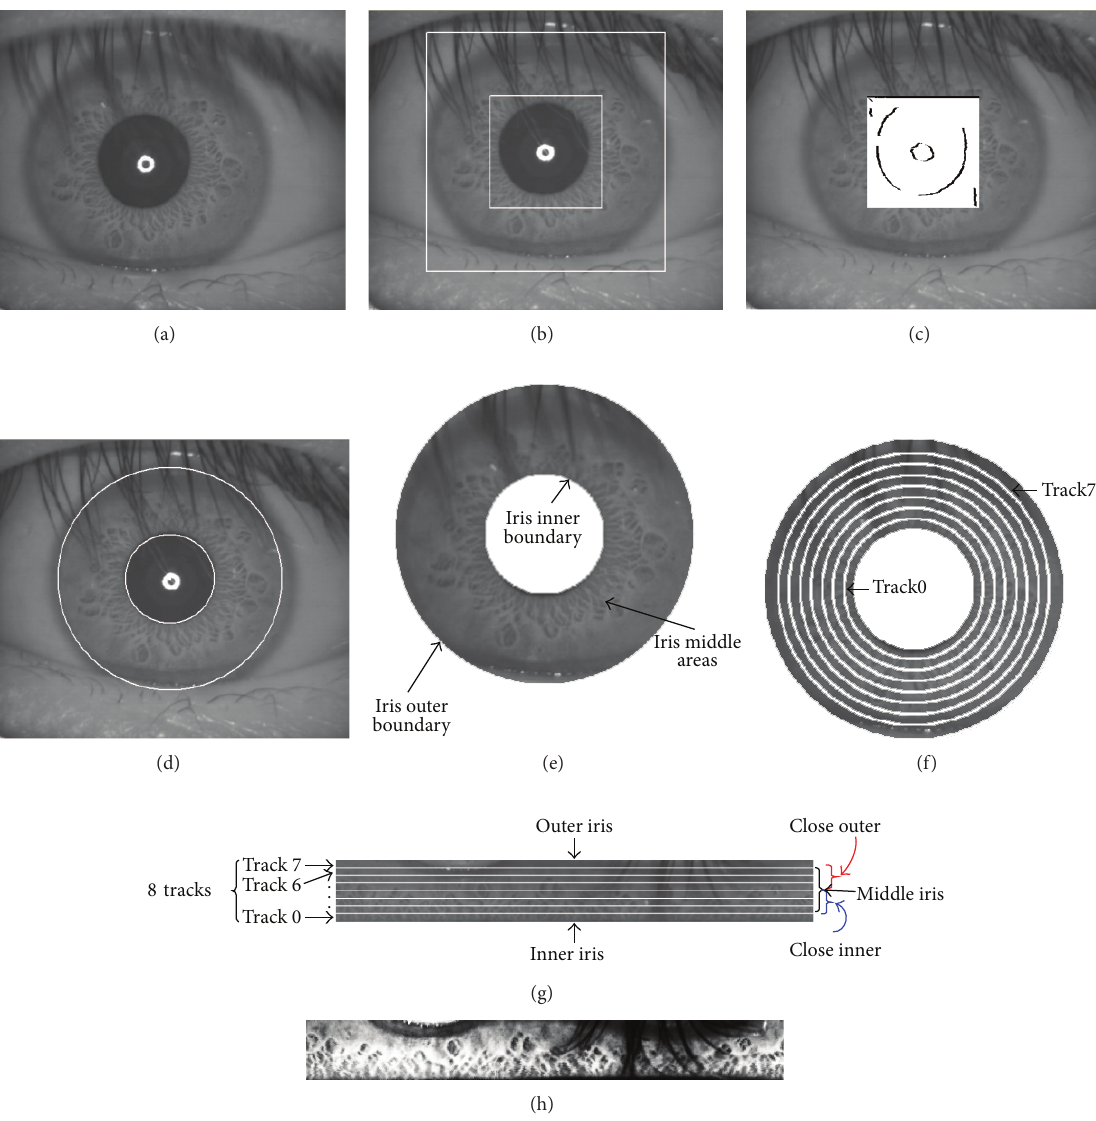
Figure 2: Steps involved in preprocessing. (a) Original iris image, (b) ROI selection, (c) Canny transformation, (d) pupil and limbic localization, (e) iris region segmentation, (f) iris region is divided into circular regions, (g) iris region is divided into 8 parts labeled with track0, track1, ... , track7 from bottom to top, and (h) enhanced image after histogram